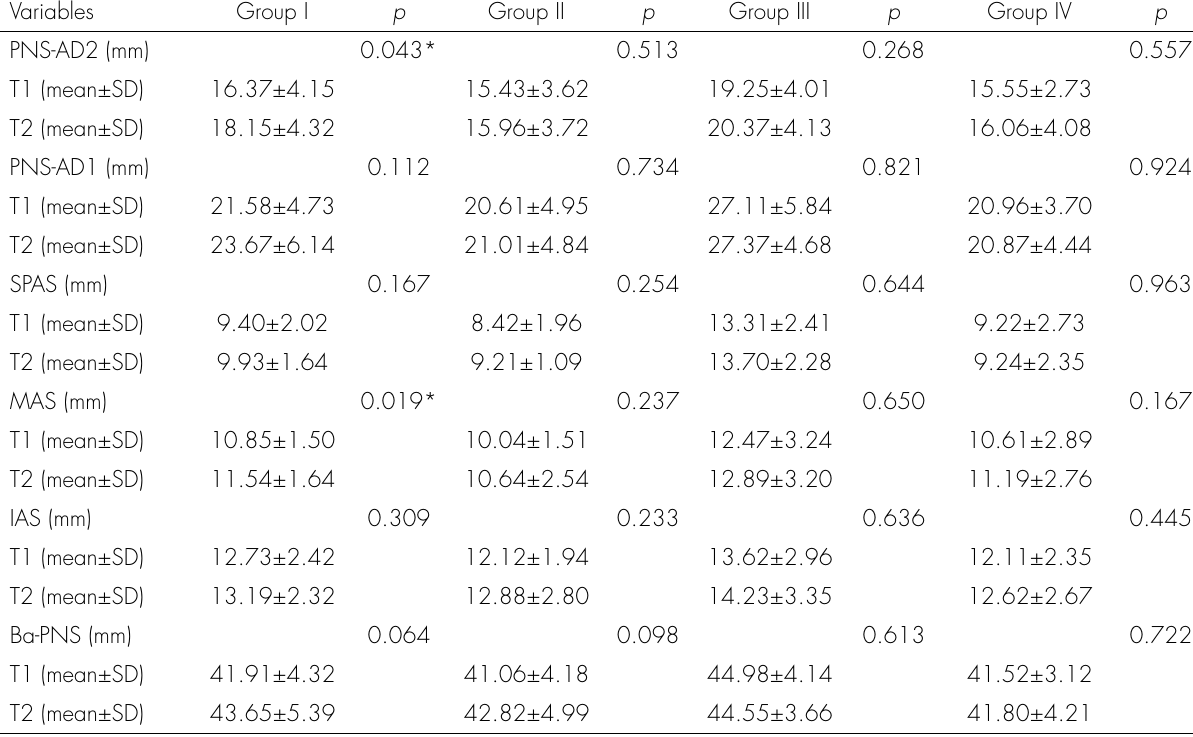
Table V. Pre- (T1) and post-treatment (T2) airway measurements of each